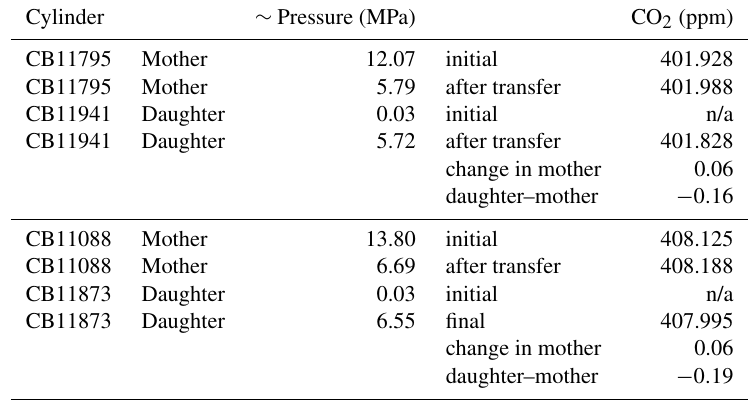
Table 5. Results of mother–daughter testing on 29.5L aluminum cylinders. Note that final pressures do not sum correctly due to thermal differences. Mother–daughter differences were calculated as daughter minus mother (after